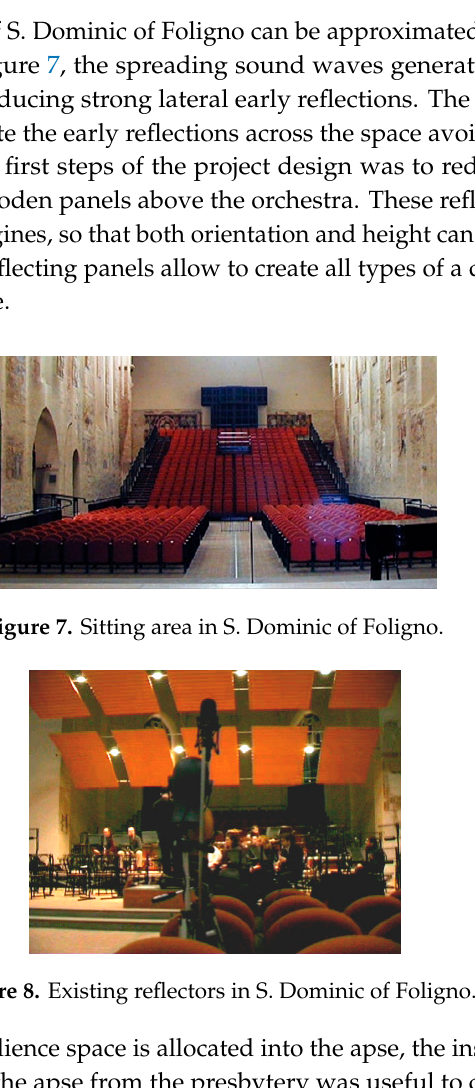
Figure 6. Proposal design of the sitting area in S. Dominic of Imola.